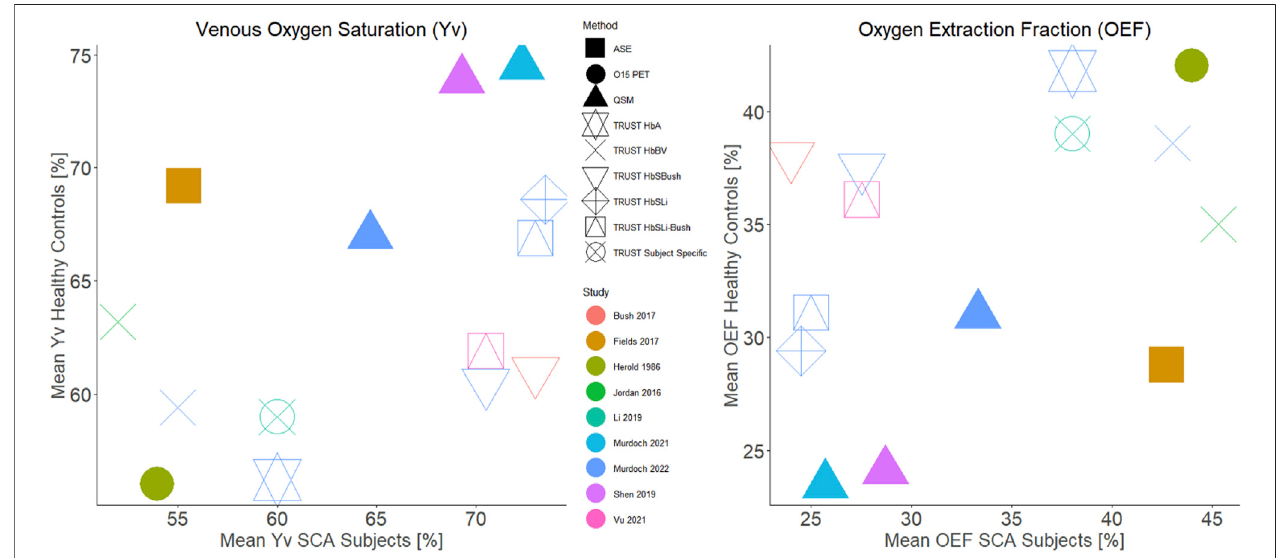
FIGURE 6 | Comparison of group mean venous oxygen saturation (left) and oxygen extraction fraction (right) in sickle cell anemia and healthy controls cohorts reported in previous literature. The points are colour coded by study and have symbols corresponding to the measurement technique used. For studies which did not report both the oxygen extraction fraction and venous oxygen saturation, the missing values were calculated assuming an arterial oxygenation of 98%.